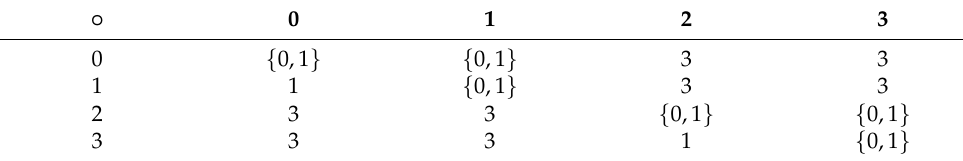
Table 12. Generalized anti-grouped quasi-hyper BZ -algebra.